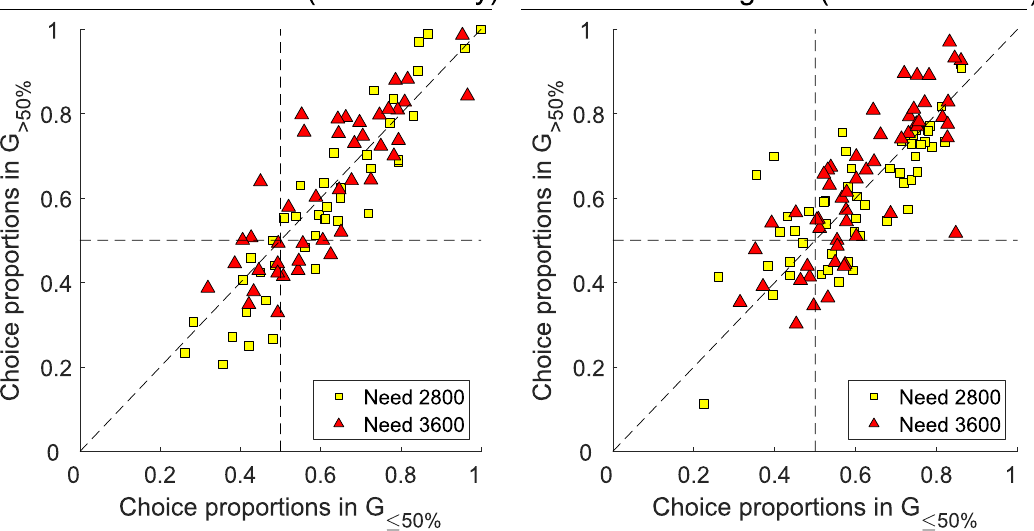
Fig 3. Proportions of choosing the gamble in G > 50% as a function of the proportion of choosing the gamble in G � 50% for each participant. Left: decisions about losses (current experiment). Right: decisions about gains (study by Diederich et al. [17]). The x- axis displays choice proportions in trials in which the participant has lost/collected 0 to 1,400 points in the Need 2,800 condition; and lost 0 to 1,000 of 5,600 points (left) or collected 0 to 1,800 points (right) in the Need 3,600 condition, respectively (0 to 50% of need). The y-axis displays choice proportions in trials in which the participant has lost/collected 1,401 to 2,800 points in the Need 2,800 condition; and lost 1,001 to 2,000 of 5,600 points or collected 1,801 to 3,600 points in the Need 3,600 condition, respectively (50 to 100% of need). Squares correspond to Need 2,800 and triangles to Need 3,600 condition.